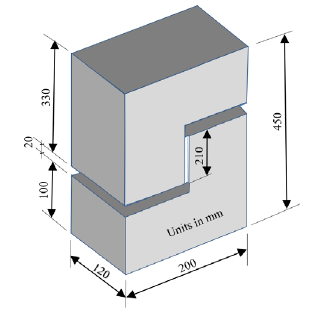
Figure 1. Push-off specimen